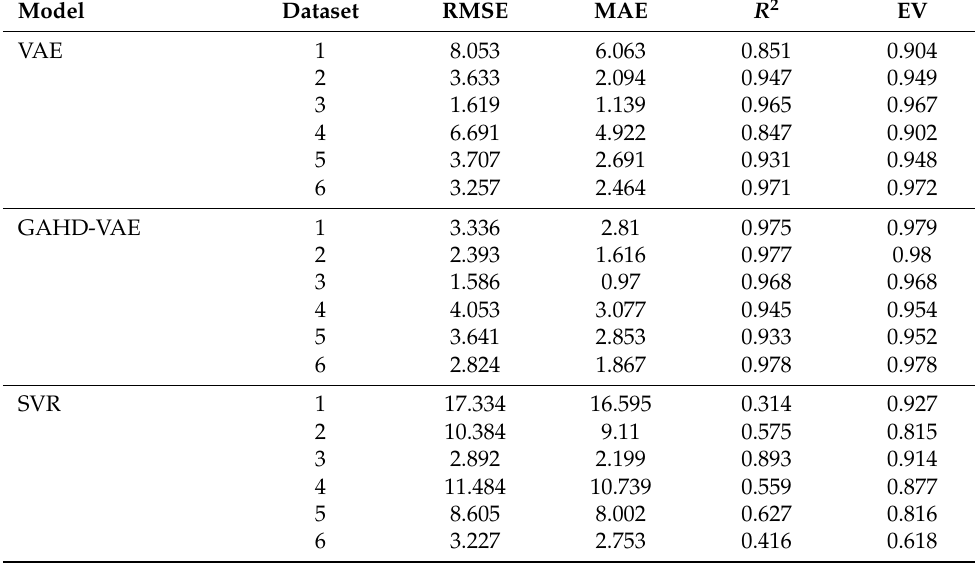
Table 3. Performance comparison of the proposed GAHD-VAE, traditional VAE, SVR, LR, RR, and